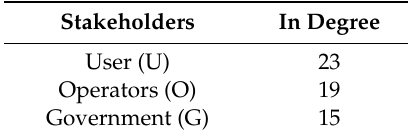
Table 6. The number of inputs for